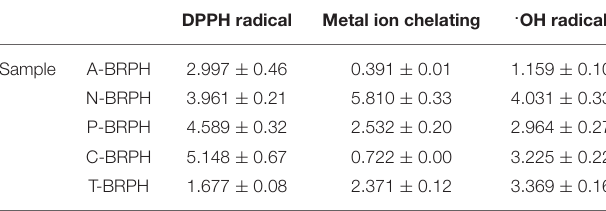
TABLE 3 | The IC 50 value of